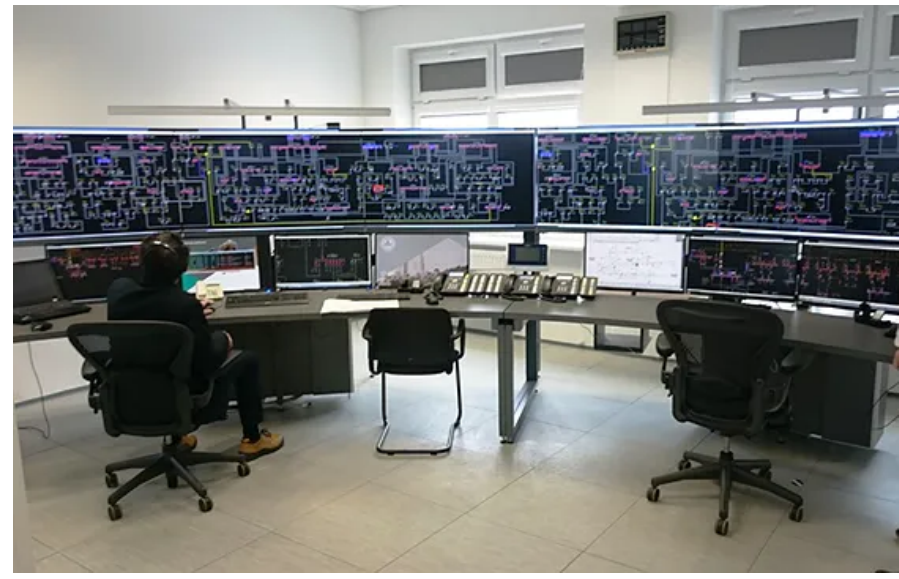
Figure 3. One Control Room in KGHM OZG Polkowice-Sieroszowice mine (source: http://polskamiedz.wp.pl/artykul/kopalnie-kghm-jak-w-filmowym-avatarze-gornik-pod-